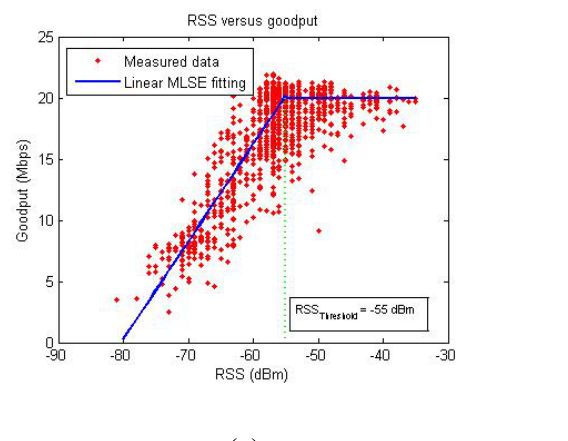
Figure 3. Relationship between the radio signal strength (RSS) and the goodput measurements. ( a ) Scatter plot depicting the measured goodput values against the RSS in various receivers at different time instants; ( b ) RSS and goodput values measured by a relay node at various positions and instants in a non-LOS (NLOS)